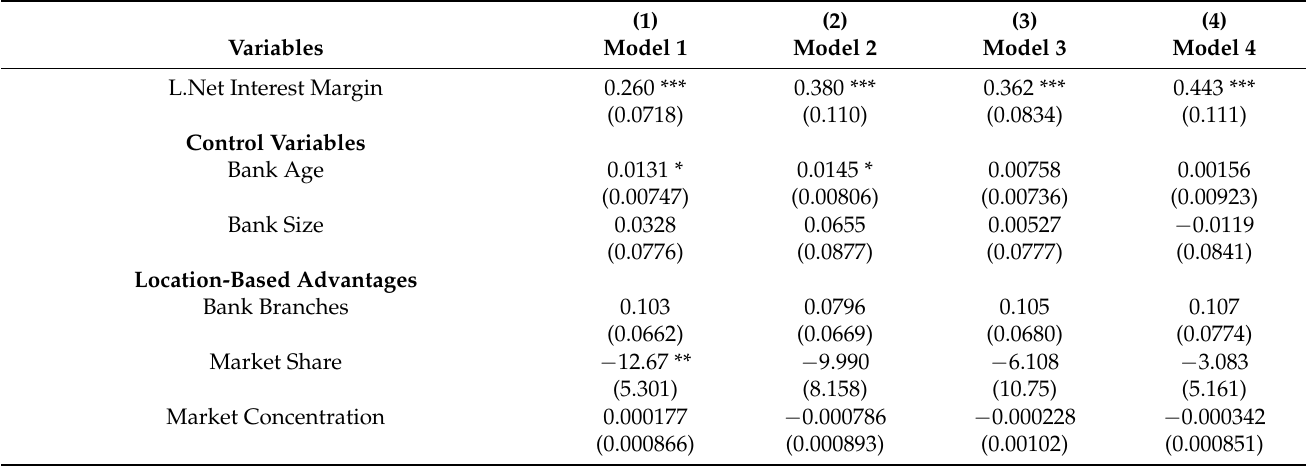
Table 13. Model of comparing dynamic cost of foreign liability with firm-specific advantages (H4) in period: